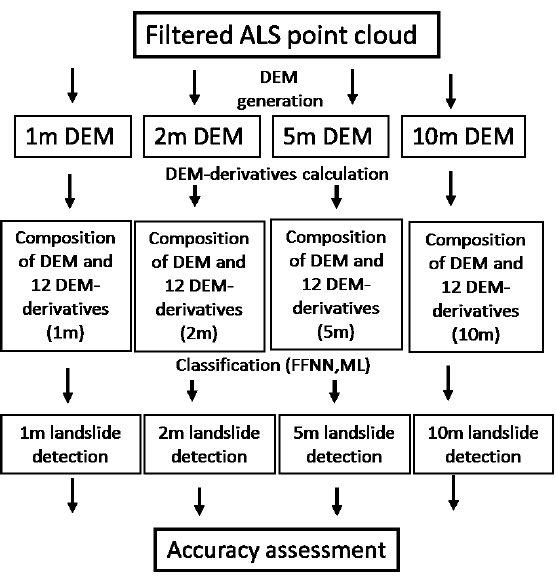
Figure 2. Methodology flow